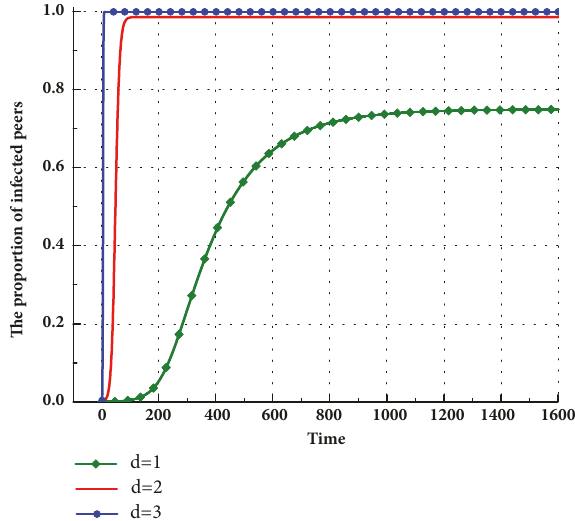
Figure 3: The impact of 𝑑 on the infected peers with 𝛽 = 0.0021 and 𝛾 = 0.0019 .